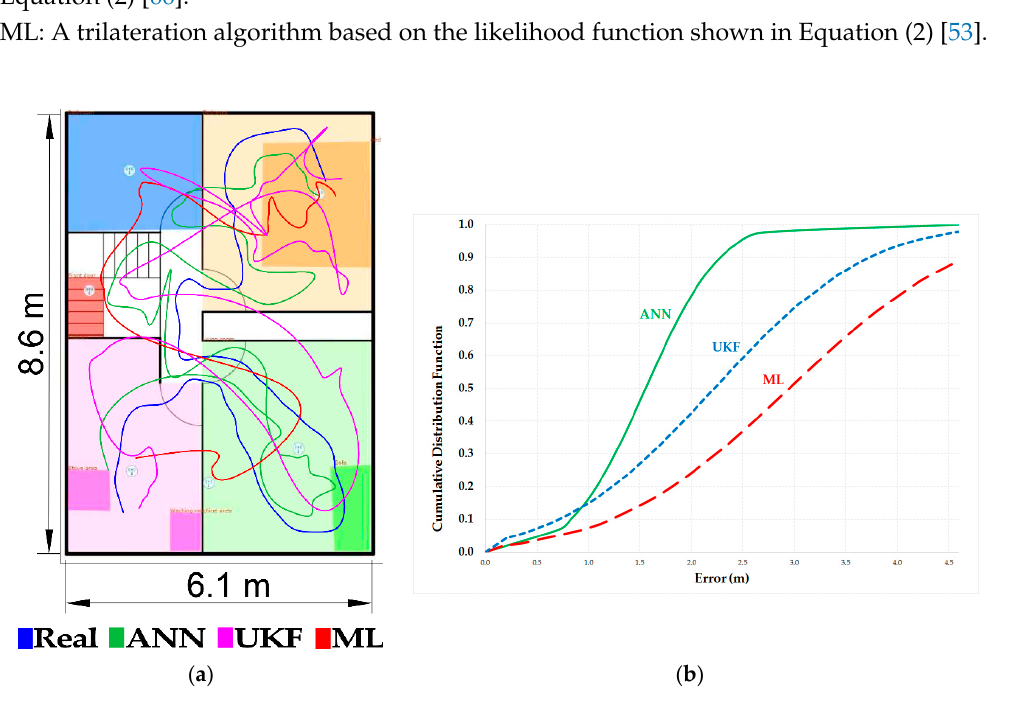
Figure 6. The presented localization algorithm remarkably outperforms conventional localization techniques based on UKF and ML. ( a ) The real route and the detected by the different techniques. ( b ) The error obtained with each technique regarding the real route. ( b ) The error obtained with each technique regarding the real